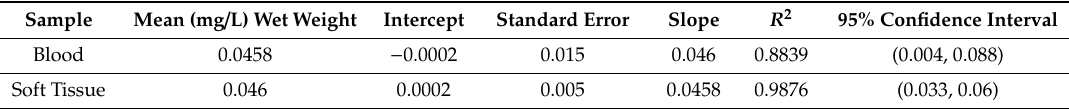
Table 3. Estimated nitrite accumulation curves of Tegillarca granosa after 72 h of exposure to nitrite b. Sample